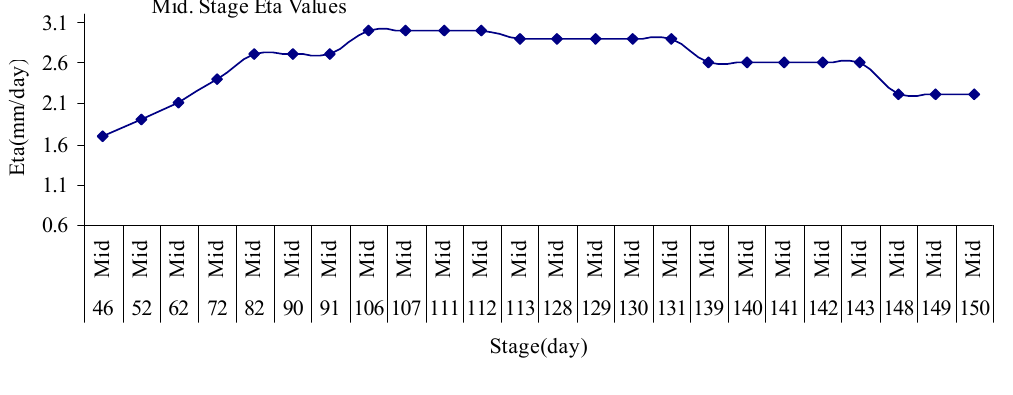
Figure 13. Dev. Stage water requirement.